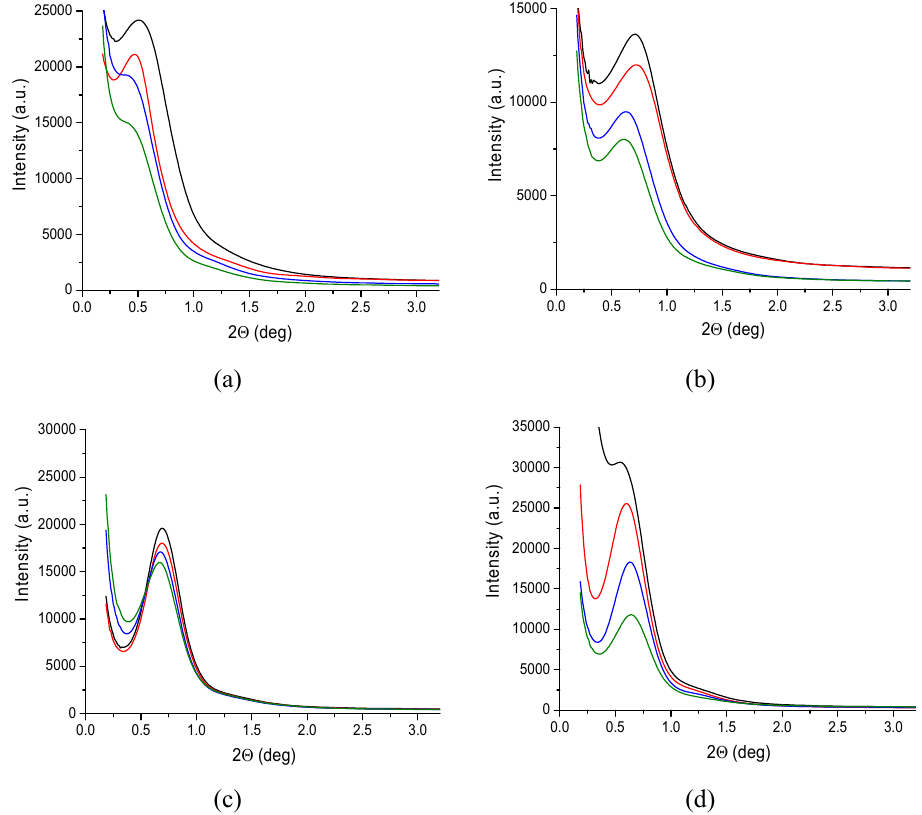
Figure 9. Small-angle X-ray scattering (SAXS) patterns of polypropylene fibers: ( a ) gravity spun; fibers taken at ( b ) 50 m/min; ( c ) 200 m/min; ( d ) 800 m/min. In the drawings, black curves refer to fibers of pure polypropylene, while red, blue, and green curves refer to fibers of iPP with rGO-CP in the amount of 0.1, 0.5, and 1.0 wt.%, respectively.